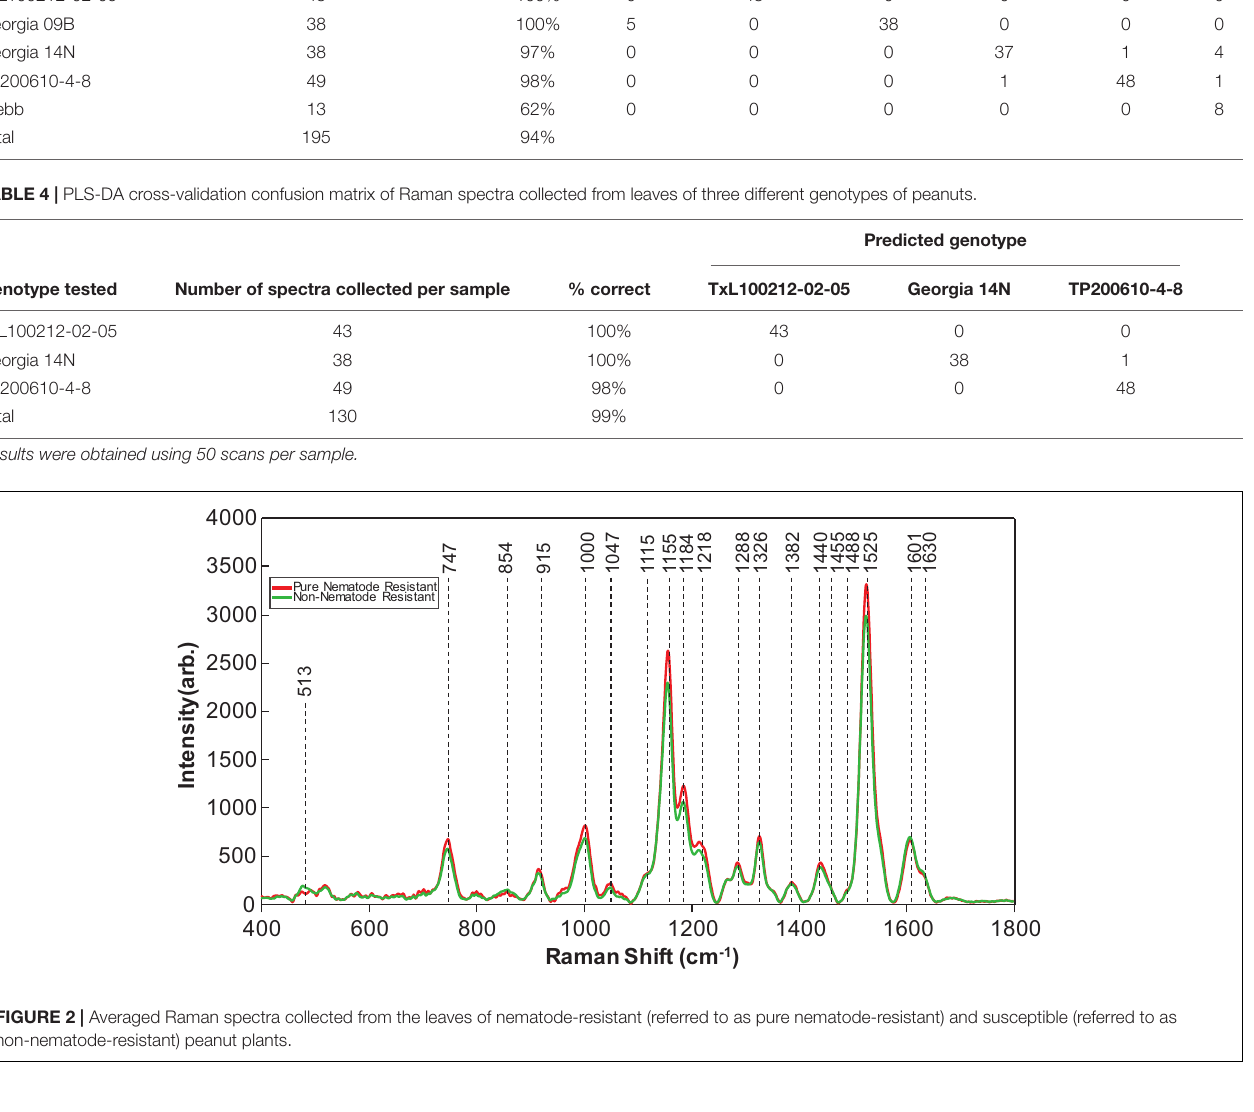
TABLE 3 | PLS-DA cross-validation confusion matrix of Raman spectra collected from leaves of six different genotypes of peanuts. Results were determined using 50 scans per member sample.